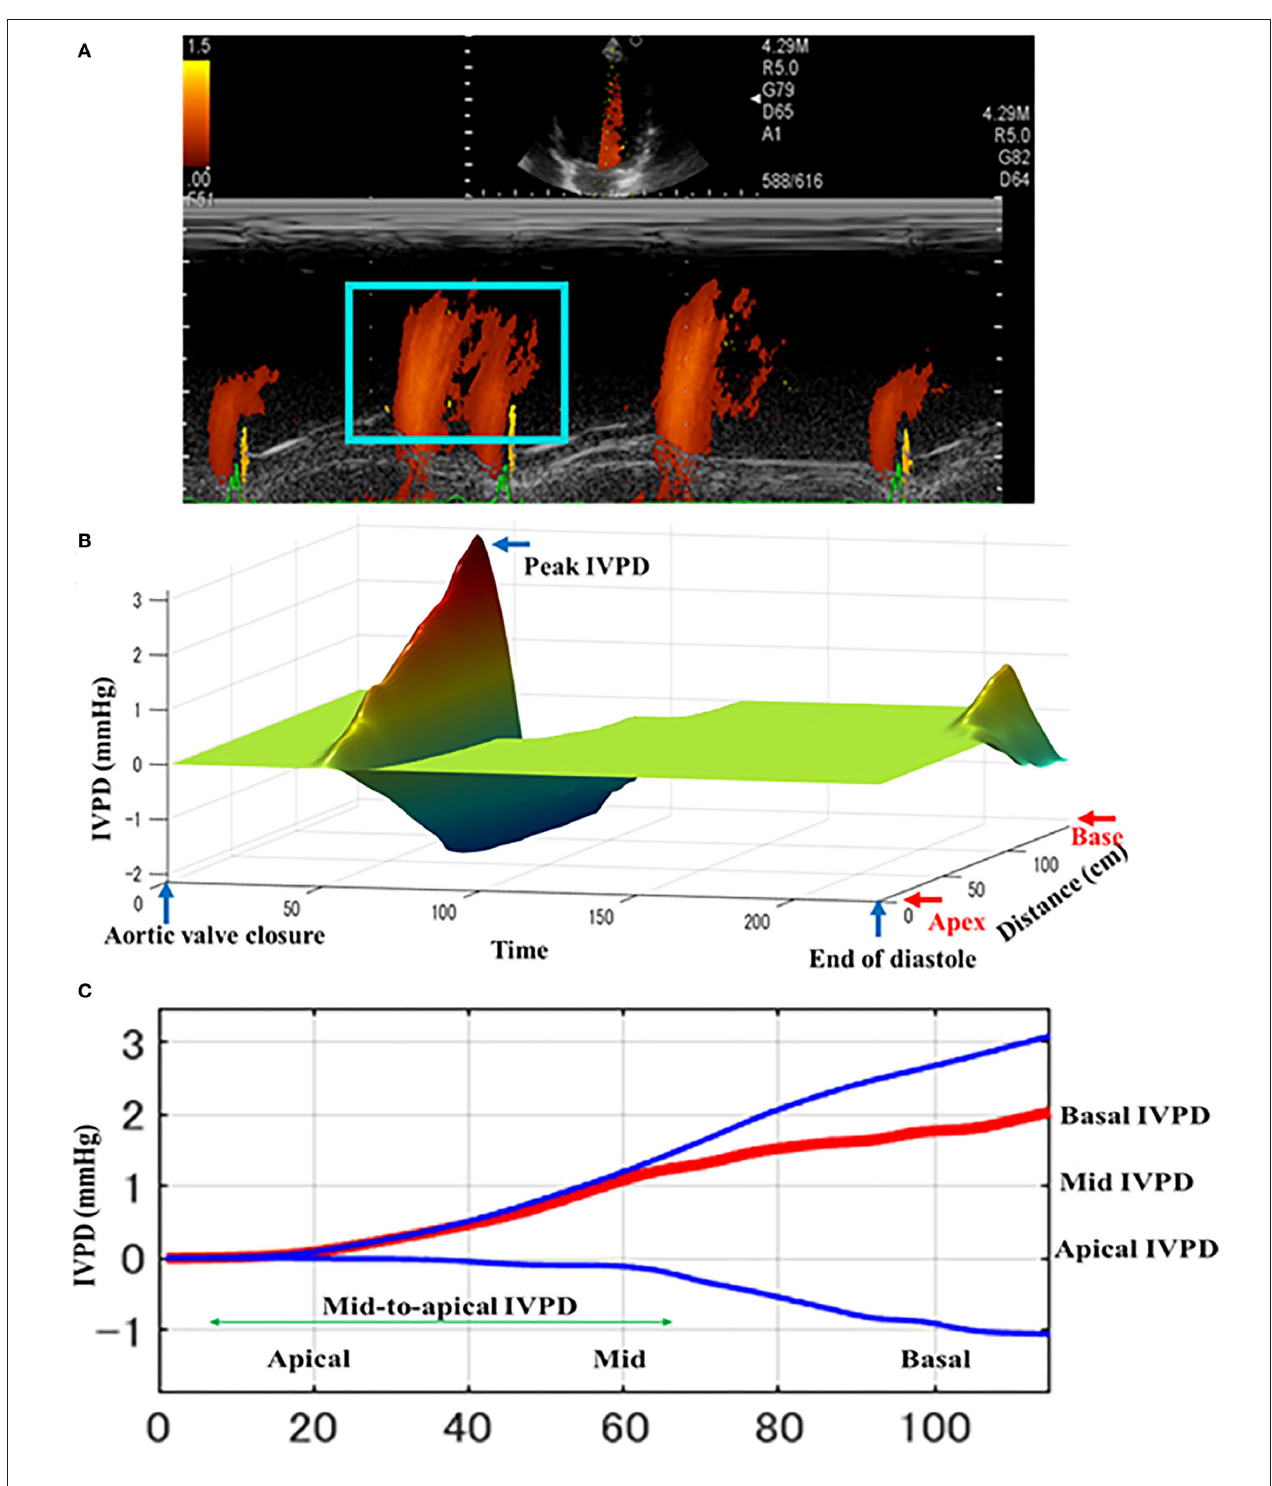
FIGURE 2 | Schematic illustration of intraventricular difference (IVPD) measured by Color m-mode echocardiography (CMME) in dogs before PDA occlusion. The mitral inflow was firstly optimized from the left apical four-chamber view. After that, the machine setting for CMME to measure IVPD (IVPG) was switched on and photos were captured (A) . Offline saved photos were further processed by MATLAB software for IVPD and IVPG calculation. The three-dimensional profile of IVPD was calculated after extraction of the velocity, temporal, and spatial elements from the region of interest (blue box) (B) . Spatial distribution of the IVPD along the entire left ventricle from the base toward the apex (C) . The top (blue), middle (red), and bottom (blue) lines represent inertial, total, and convective IVPD, respectively.